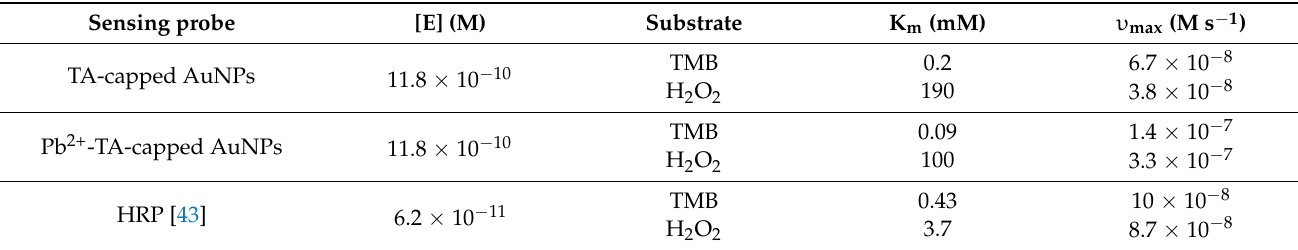
Figure 5. Kinetic dependences of Michaelis-Menten and their linear transformations in double reciprocal plots (Lineweaver–Burk plots) for TA-capped AuNPs with (a, black lines) and without (b, red lines) Pb 2+ ions varying the concentration of TMB from 0.2 to 1 mM with a fixed concentration of H 2 O 2 at 0.5 M ( a,b ) and varying the concentration of H 2 O 2 from 0.1 to 0.6 M with a fixed TMB at 0.5 mM ( c , d ). ( N = 3). The values of deviations from the mean at the points for figures a–d are, respectively, 0.6–4.6%, 0.6–5.8%, 0.5–5.5%, 0.5–4.1%. Table 1. Comparison of kinetic parameters (K m and υ max ) of the oxidation reaction catalyzed by HRP and the proposed colorimetric probe.